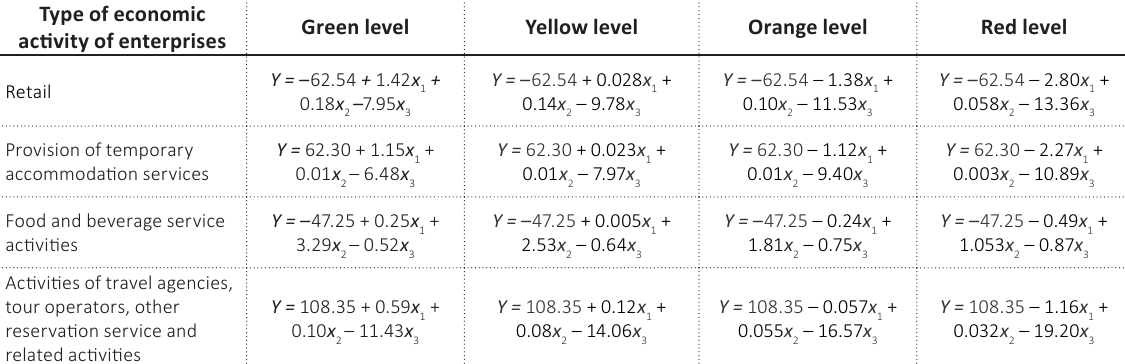
Table 5. The system of dependence equations of the turnover dynamics of retail trade, hotel and restaurant and tourism business on the selected macroparameters under various pandemic scenarios